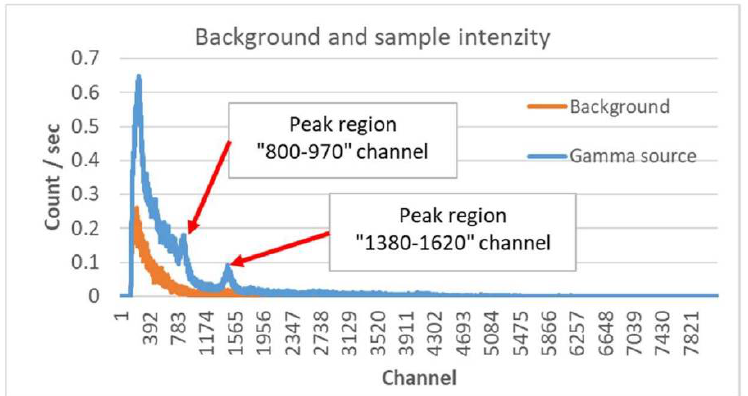
Figure 4. The spectrum of the static sensitivity test of the detector for background radiation (orange) and Autunite source (blue).